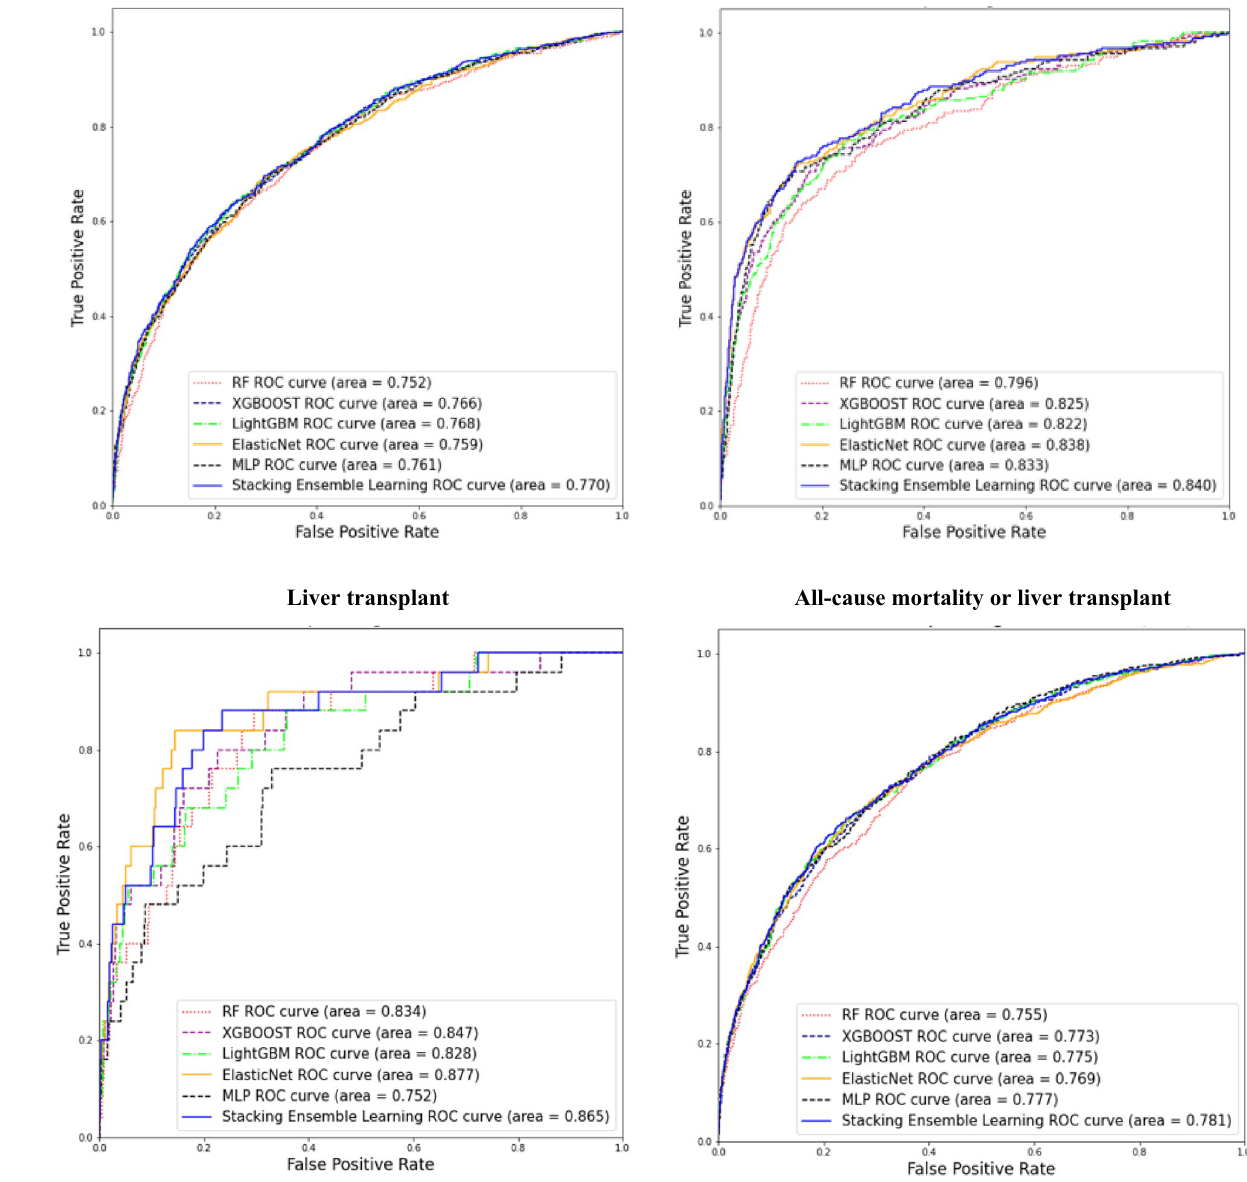
Figure 5. ROC curves for the trained classifiers in the Test Set from one Training-Set split for patients with any liver disease (N =